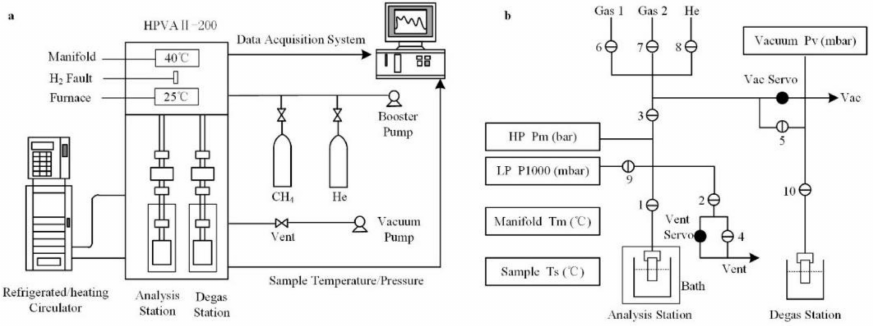
Figure 2. Schematic diagrams of ( a ) experimental system and ( b ) HPVA